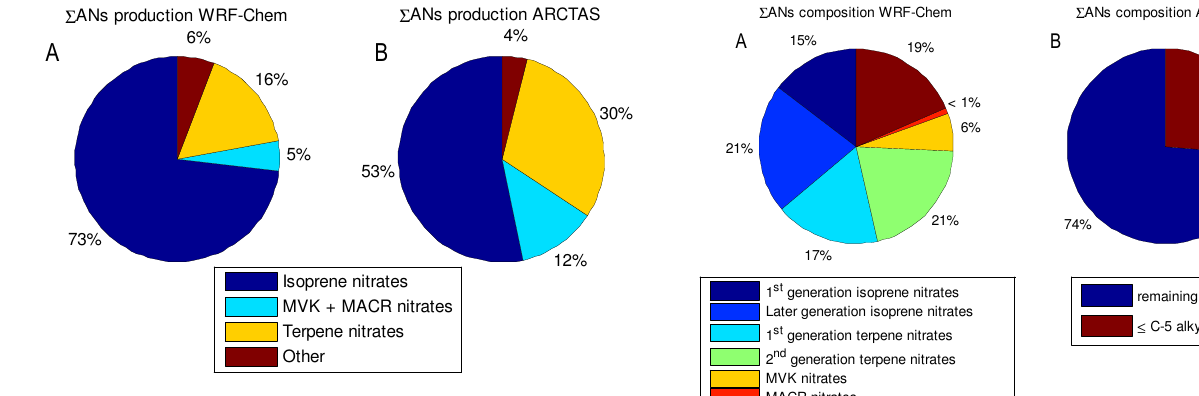
Fig. 4. (a) Instantaneous 6 ANs production rate as calculated by WRF-Chem along the ARCTAS flight track at altitudes less than 2km. (b) The calculated instantaneous 6 ANs production based on Figure 4 a) Instantaneous Σ ANs production rate as calculated by WRF-Chem along the 2 the volatile organic compound precursors measured during ARC- TAS for altitudes less than 2km. Details regarding this calculation ARCTAS flight track at altitudes less than 2 km. b) The calculated instantaneous Σ ANs 3 can be found in Browne et al. (2013). production based on the volatile organic compound precursors measured during ARCTAS for 4 altitudes less than 2 km. Details regarding this calculation can be found in Browne et al. (2013). 5